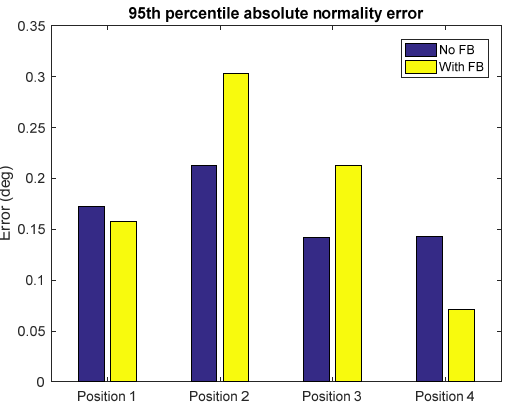
Figure 25. Summary of 95th percentile hole normality for all 4 positions.